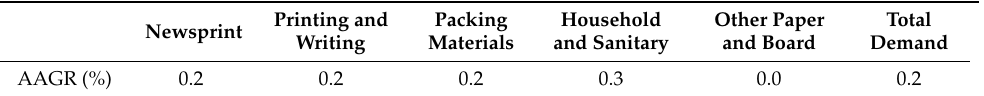
Table 10. Predictions for paper consumption used in the model (AAGR: annual average growth rate)